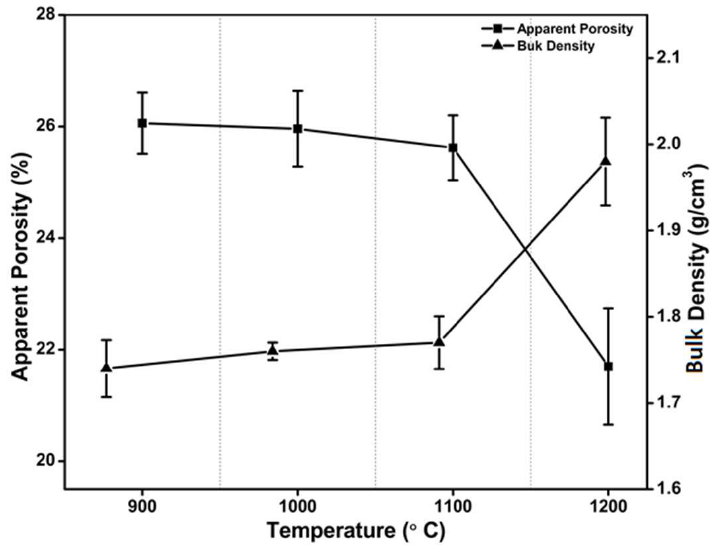
Figure 4. Variation of bulk density and apparent porosity with respect to firing temperature.